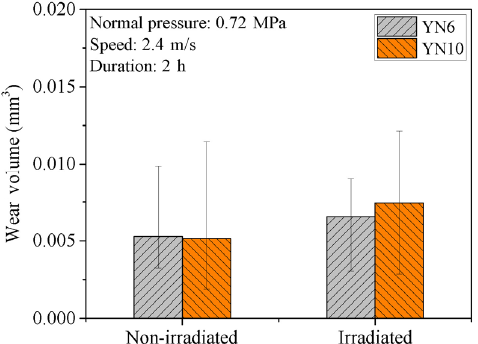
Fig. 9 Wear volume of non-irradiated/irradiated WC-Ni surfaces slid against graphite.